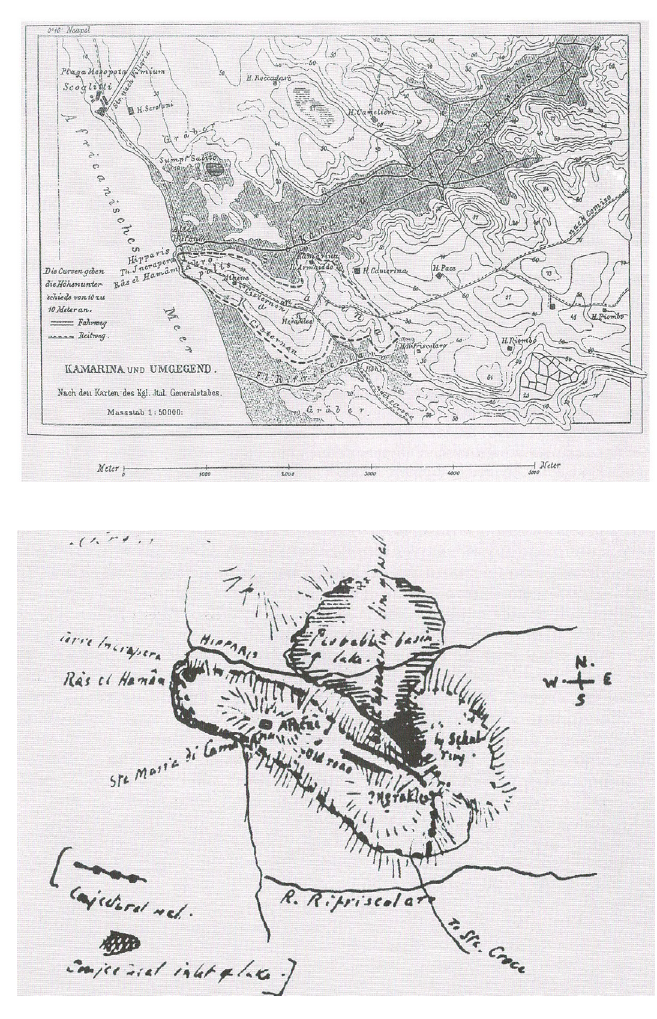
Fig. 11 Kamarina, plan by J.